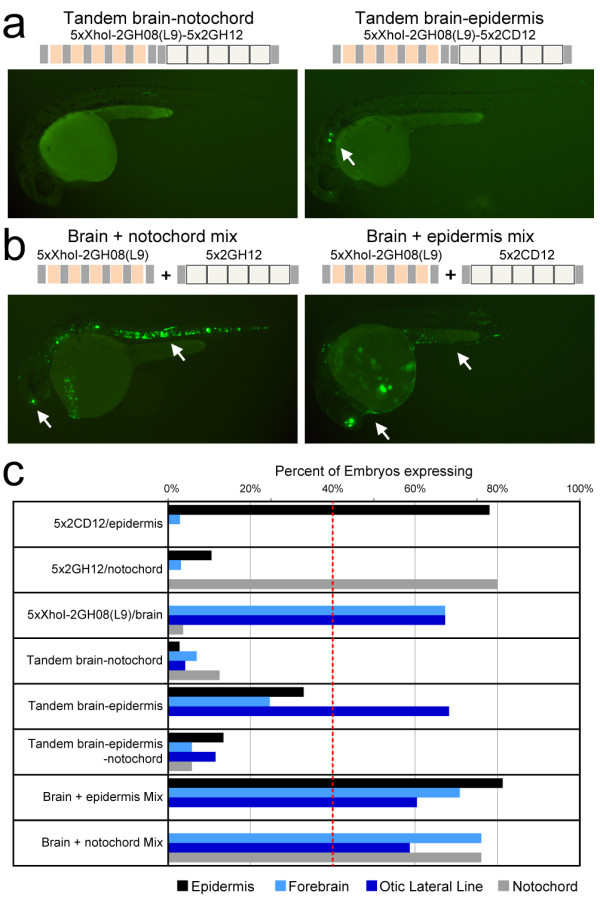
Combination of synthetic regulatory elements underscores the importance of context. (a) Left: a tandem combination of the 5xXhoI-2GH08(L9)/brain and 5x2GH12/notochord concatemers failed to produce any enhancer activity above background. Right: a tandem combination of the 5xXhoI-2GH08(L9)/brain and 5x2CD12/epidermis concatemers resulted in consistent otic lateral line expression. Expression in the forebrain and epidermis was detected inconsistently in a handful of embryos (such as the one shown), but not as intensely as the original concatemer. (b) Injection of a mixture of the 5xXhoI-2GH08(L9)/brain and 5x2GH12/notochord (left) or 5xXhoI-2GH08(L9)/brain and 5x2CD12/epidermis constructs (right) resulted in the expected combinatorial pattern (white arrows). (c) Percentage of embryos expressing in the epidermis, forebrain and notochord for the 5x concatemers individually, as combinations or as a mixture of two constructs. Tandem arrangement of concatemers in the same regulatory element largely failed to reproduce the expression patterns driven by concatemers individually or in a mixture, with the exception of the brain-epidermis combination, which preserved otic lateral line expression.